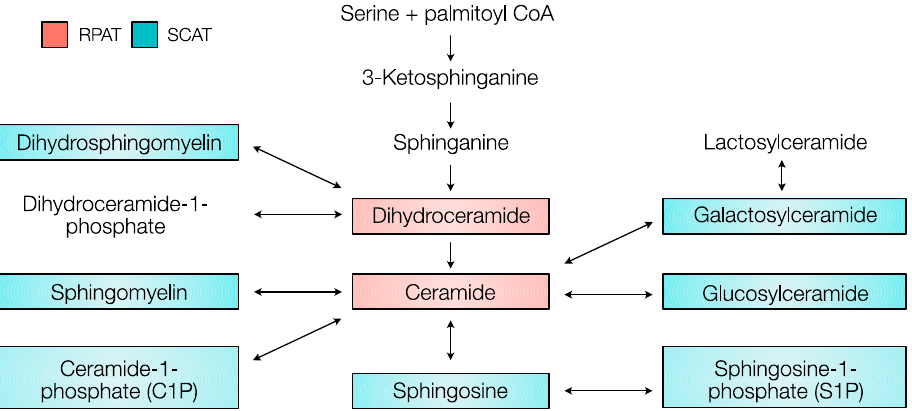
Figure 7. The concentration of sphingolipids across the sphingolipid pathways in subcutaneous (SCAT) and retroperitoneal adipose tissue (RPAT). Dihydroceramide and ceramide were more concentrated in RPAT (red) than in SCAT. Dyhydrosphingomyelin, sphingomyelin, ceramide-1-phosphate, sphingosine, sphingosine-1-phosphate, glucosylceramide, and galactosylceramide were more concentrated in SCAT (blue) than RPAT. There was no statistical difference in 3-ketosphinganine, sphinganine, dihydroceramide-1-phosphate, and lactosylceramide between RPAT and SCAT. The sphingolipid pathway map was drawn according to Merrill [8] and Maceyka and Spiegel [9].